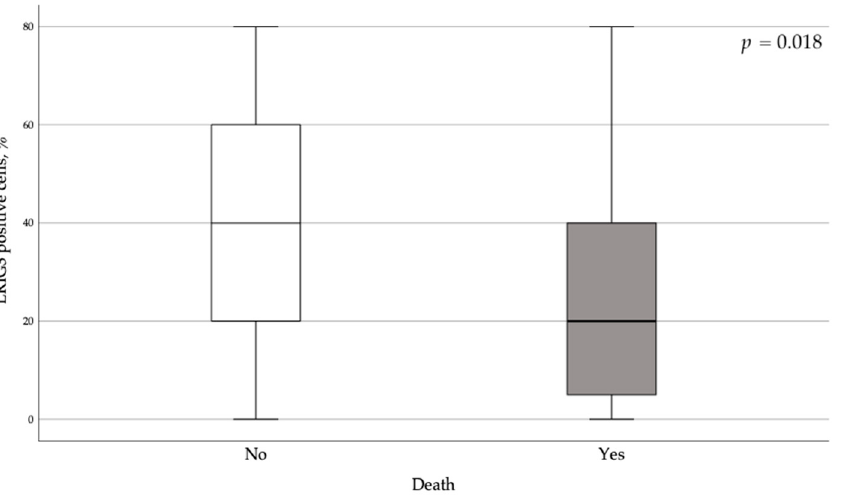
Figure 4. Percentage of LRIG3-positive cells in women who died of endometrial cancer and endome- trial cancer